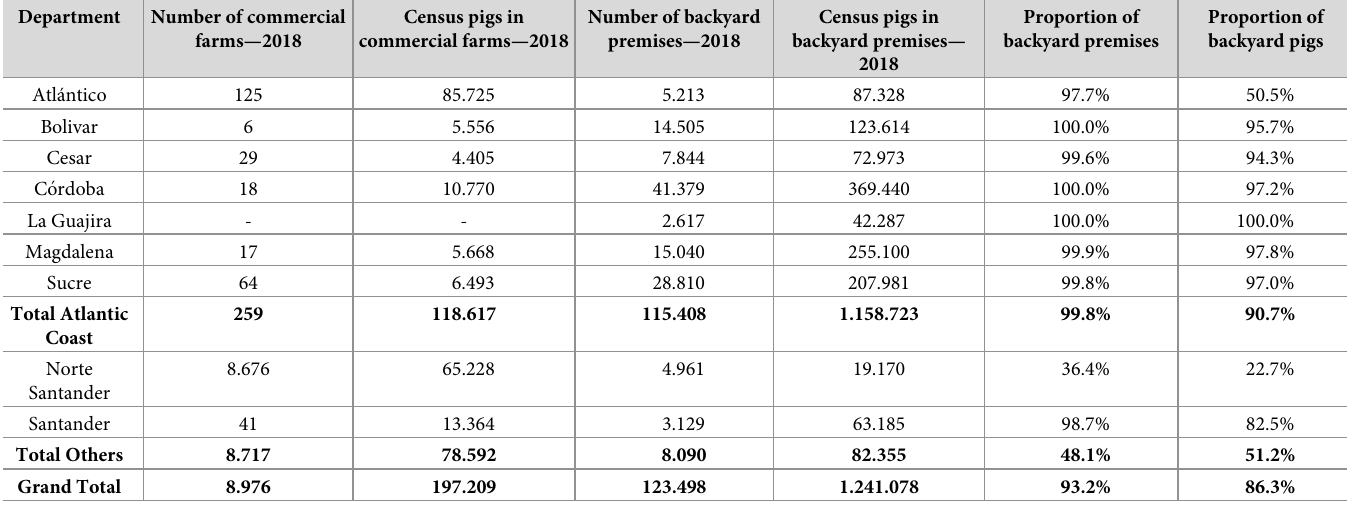
Table 1. Census of pigs in the CSF affected departments of Colombia.